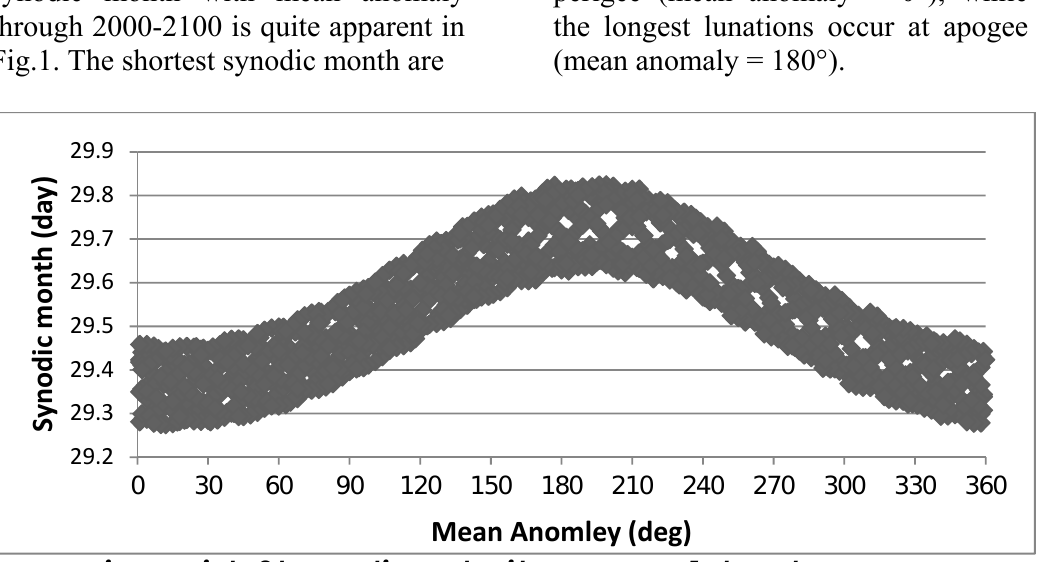
Fig.1: Period of the synodic month with mean anomaly through